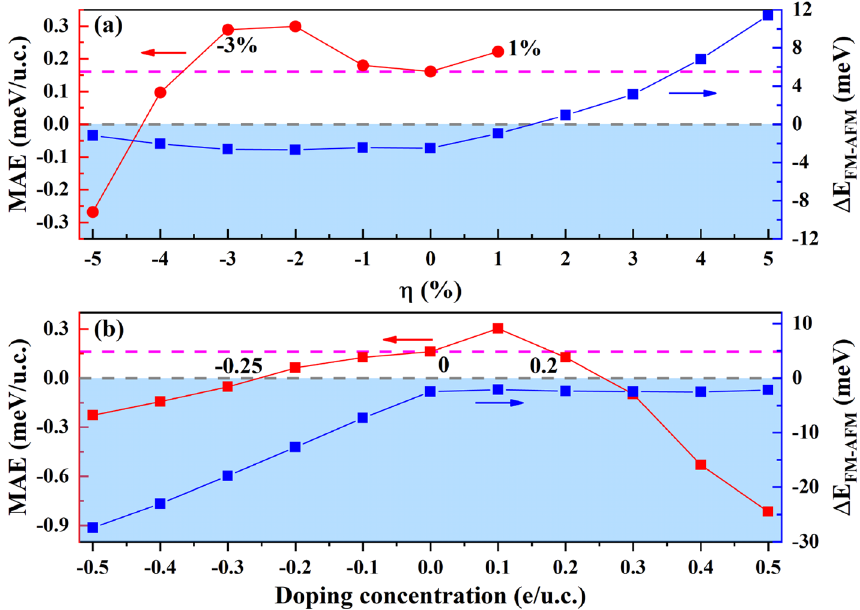
Figure 7. ( a ) Strains and ( b ) electrostatic doping concentration dependence of the magnetic anisotropy energy (MAE) and magnetic ground state for bilayer Cr 2 Ge 2 Te 6 . The arrows point to the axis for each curve in the corresponding color. The gray horizontal dashed lines denote the boundary of spin polarization or magnetic ground state. The critical range is marked over the magenta dashed line in ( a ) and ( b